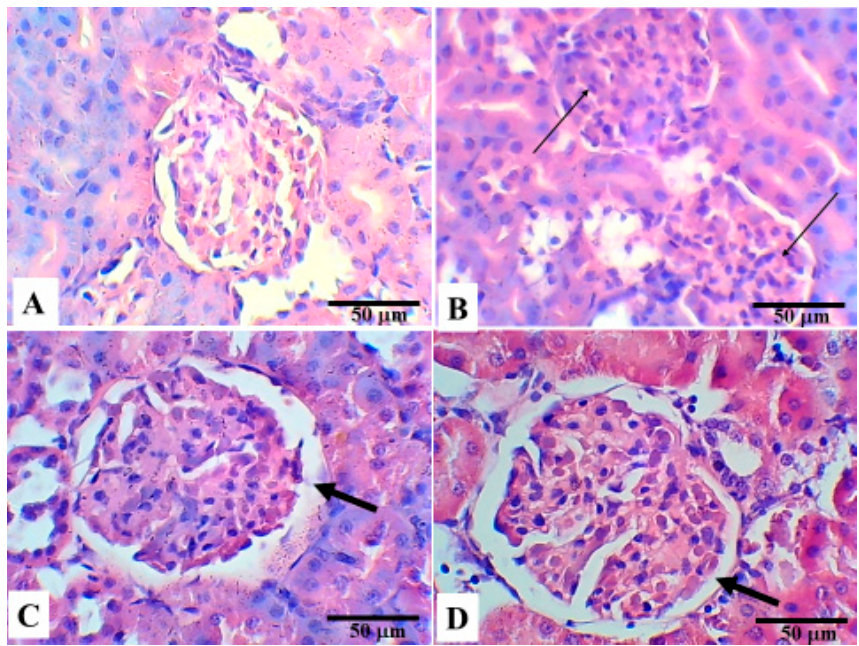
Figure 1. The glomerular changes in the four groups. When compared with the control group, the GM induced mesangial and glomerular endothelial cell proliferation (thin arrows). Additionally, note that the Bowman’s space was preserved in the TQ-treated and MF-treated groups (thick arrows). ( A ): Control group; ( B ): GM-treated group; ( C ): TQ-treated group; ( D ): MF-treated group. H&E staining. Figure 2 shows the observed tubular changes in the four groups. When compared with the control group, GM induced vacuolar degeneration of the tubular epithelium with H&E evidence of tubular necrosis and tubular irregularities. However, the hyaline droplets seen in the GM-treated group were visibly reduced in the TQ-treated and MF-treated groups. In addition, the tubular regularity was preserved, the tubular vacuolar degenera- tion was reduced, and the ameliorative effects were increased in the TQ-treated group. These finding suggest that TQ has more protective effects especially at the tubular level than those of MF.